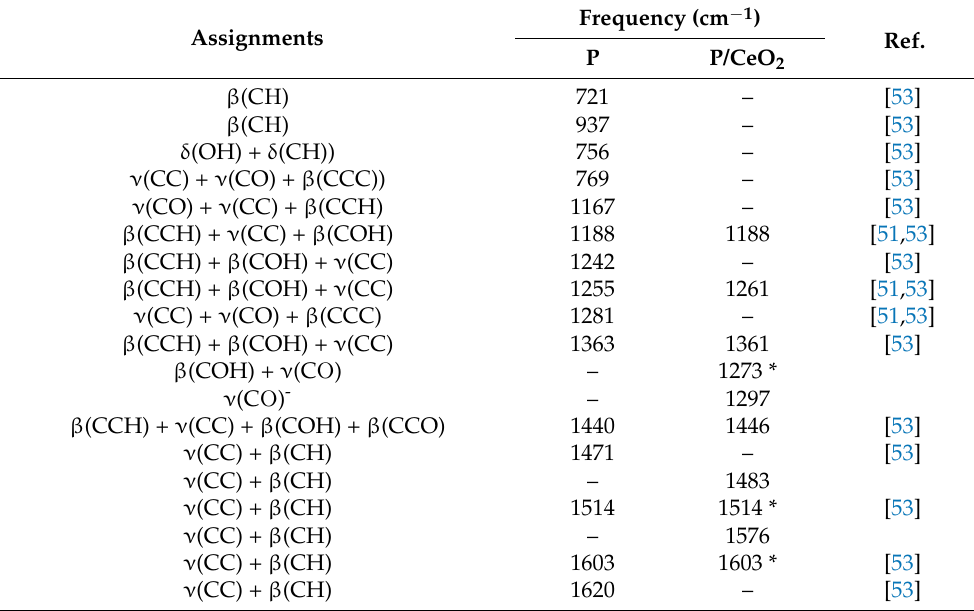
Table 1. Assignments of infrared bands of pure P and of P/CeO 2 (0.6